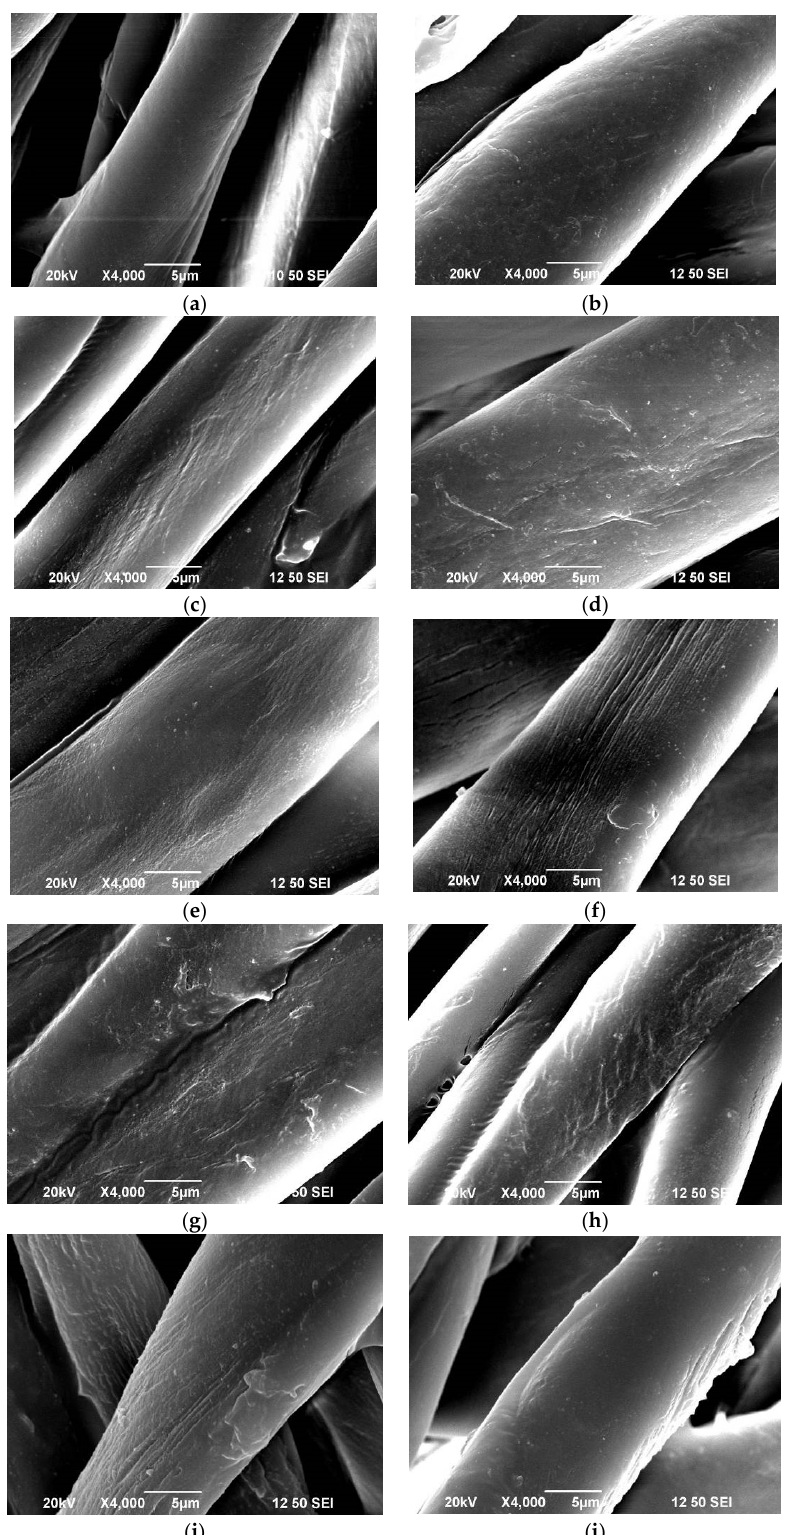
Figure 2. SEM images of ( a ) untreated cotton fiber; plasma treated cotton fiber with ( b ) sample 1; ( c ) sample 2; ( d ) sample 3; ( e ) sample 4; ( f ) sample 5; ( g ) sample 6; ( h ) sample 7; ( i ) sample 8; and ( j ) sample 9 with respective treatment parameter settings after pigment dyeing.